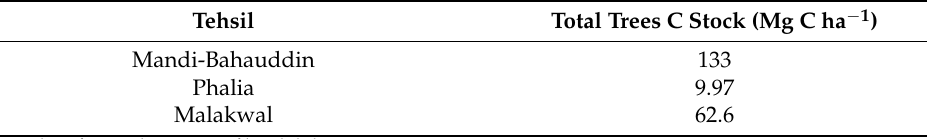
Table 5. Total Tree Carbon stock.